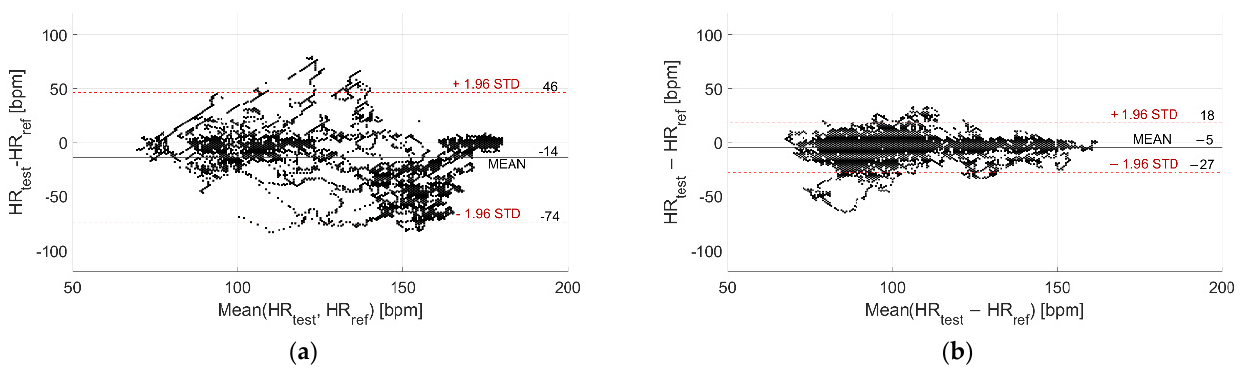
Figure 6. Bland–Altman plot related to ( a ) In-water and ( b ) Dry acquisitions, including recordings both at rest and during moderate physical activities performed with Polar Vantage V2 (reference instrument: Polar H10).